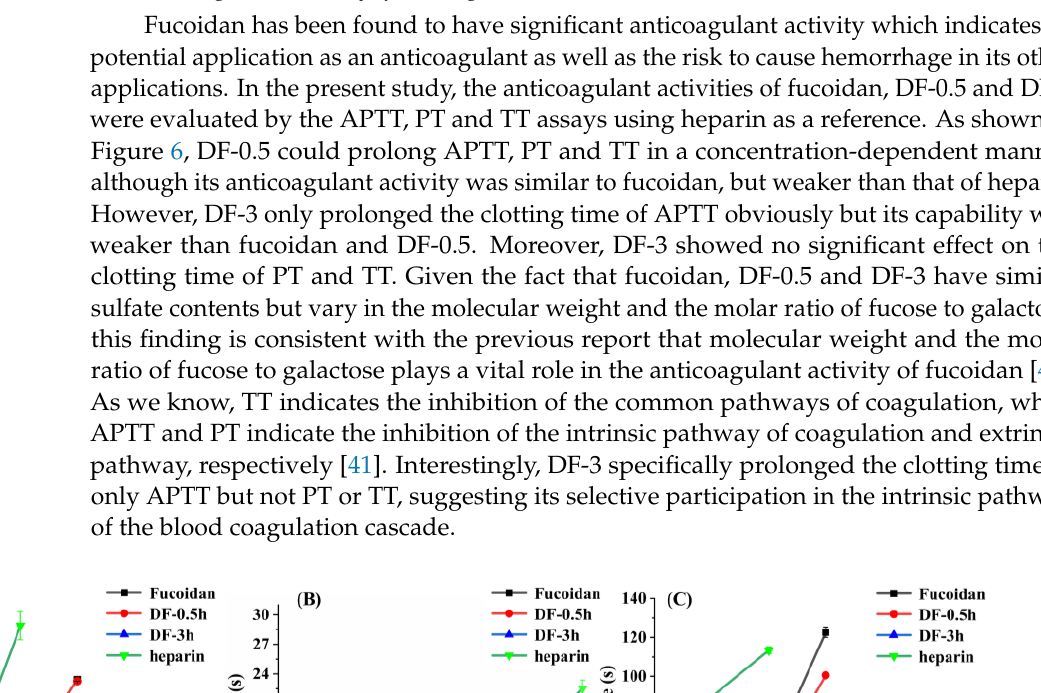
Figure 5. Effects of the degraded fucoidans on the HT-29 cell proliferation. Results were presented as mean ± SD (n = 6). ** p < 0.01 indicate statistically significant differences from the control group.